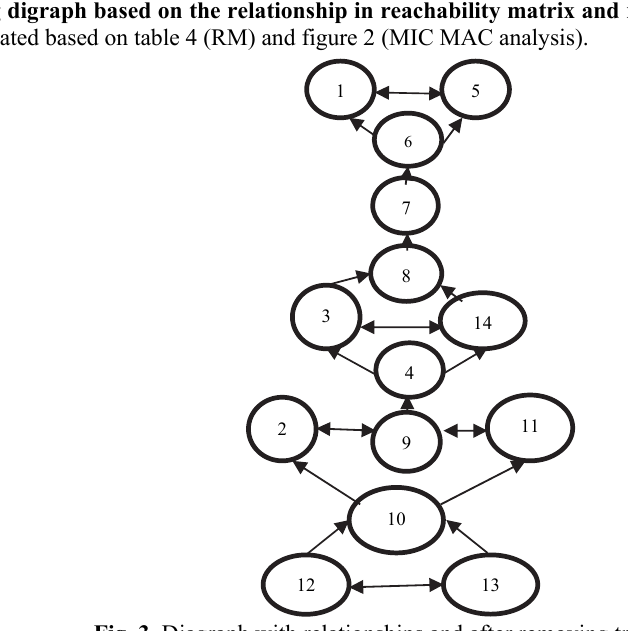
Fig. 3. Diagraph with relationships and after removing transitive